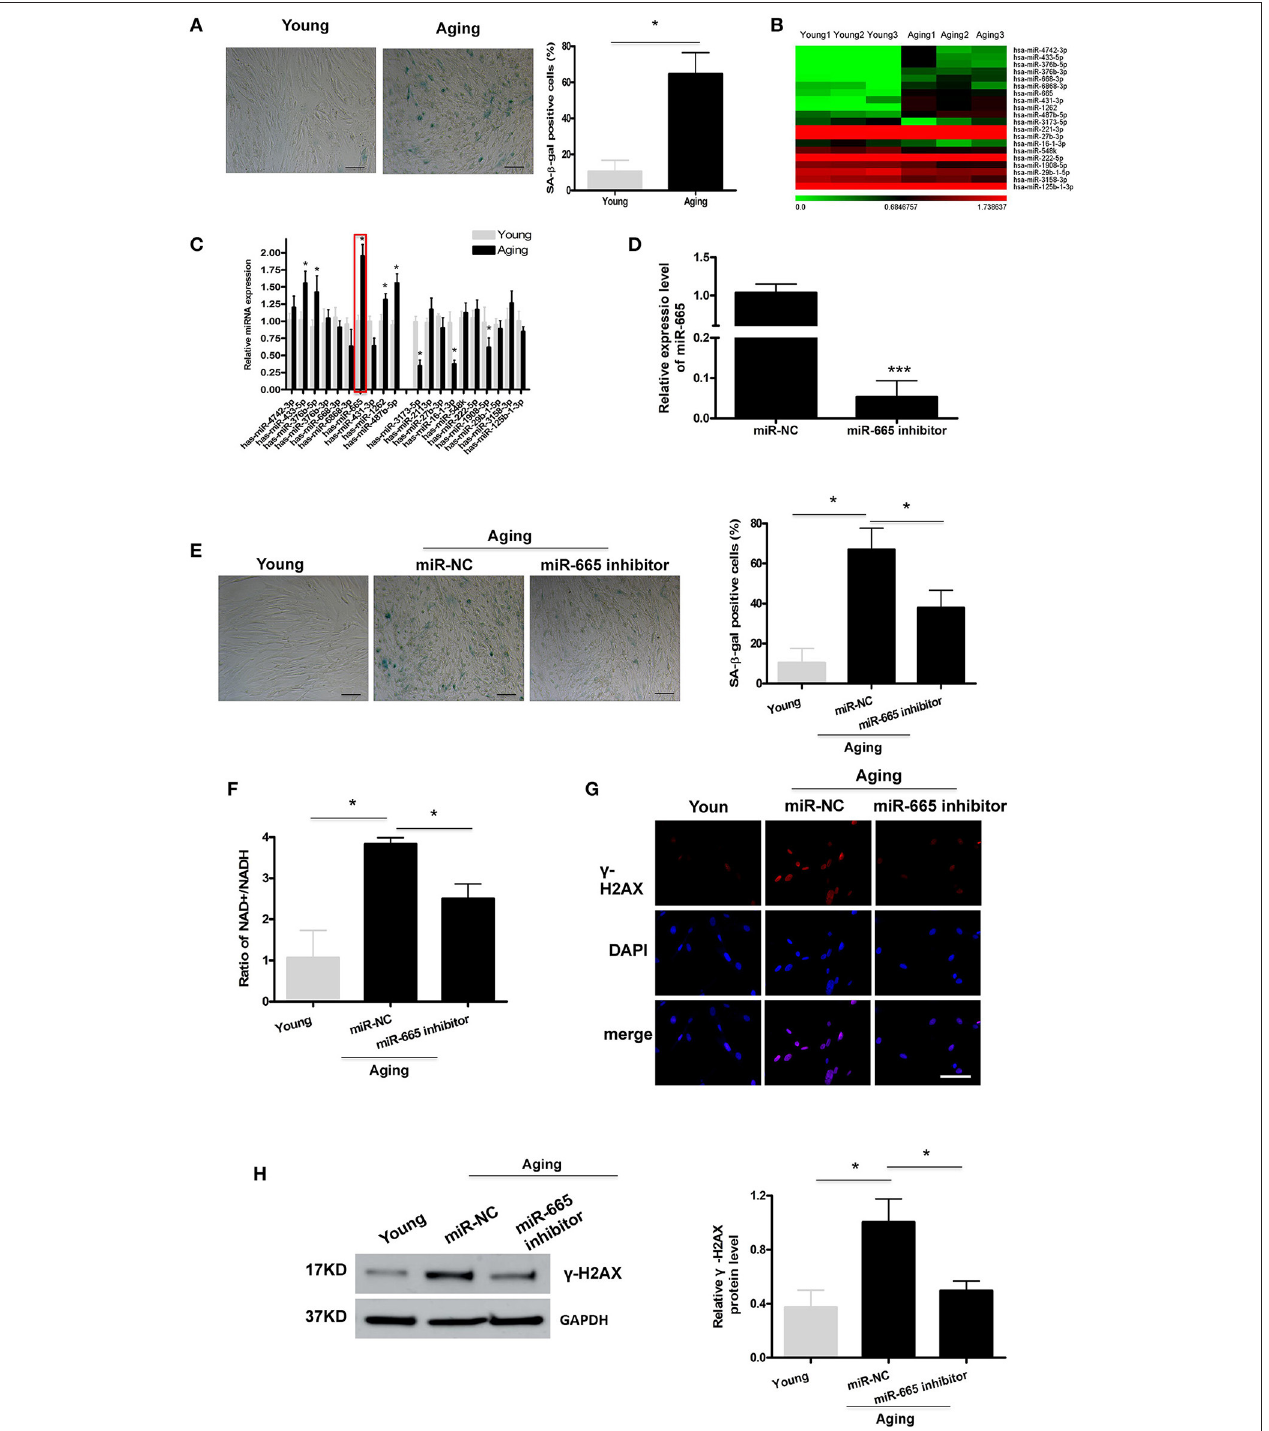
FIGURE 1 | MiR-665 is involved in the regulation of VSMC senescence. (A) Representative photomicrographs and average data of SA β -gal staining (blue) in young and aging VSMCs. Scale bar indicates 50 µ m. * P < 0.05; Original magnification × 100. (B,C) Top 20 DEMs in young and aging VSMCs as determined via microarray analysis and qRT-PCR assays. * P < 0.05 compared with young groups. (D) qRT-PCR-based determination of miR-665 inhibition efficiency in aging VSMCs. *** P < 0.001. (E) Representative photomicrographs and average data of SA β -gal staining in young VSMCs and aging VSMCs transfected with miR-665 inhibitor or miR-NC. Scale bar indicates 50 µ m. * P < 0.05; Original magnification × 100. (F) Representative average ratio of NAD + /NADH in young VSMCs and aging VSMCs transfected with miR-665 inhibitor or miR-NC. * P < 0.05. (G) Representative immunofluorescence assay of γ -H2AX in young and aging VSMCs transfected with miR-665 inhibitor or miR-NC. * P < 0.05; Scale bar indicates 20 µ m. (H) Representative Western blot assays of γ -H2AX in young and aging VSMCs transfected with miR-665 inhibitor or miR-NC. * P < 0.05.